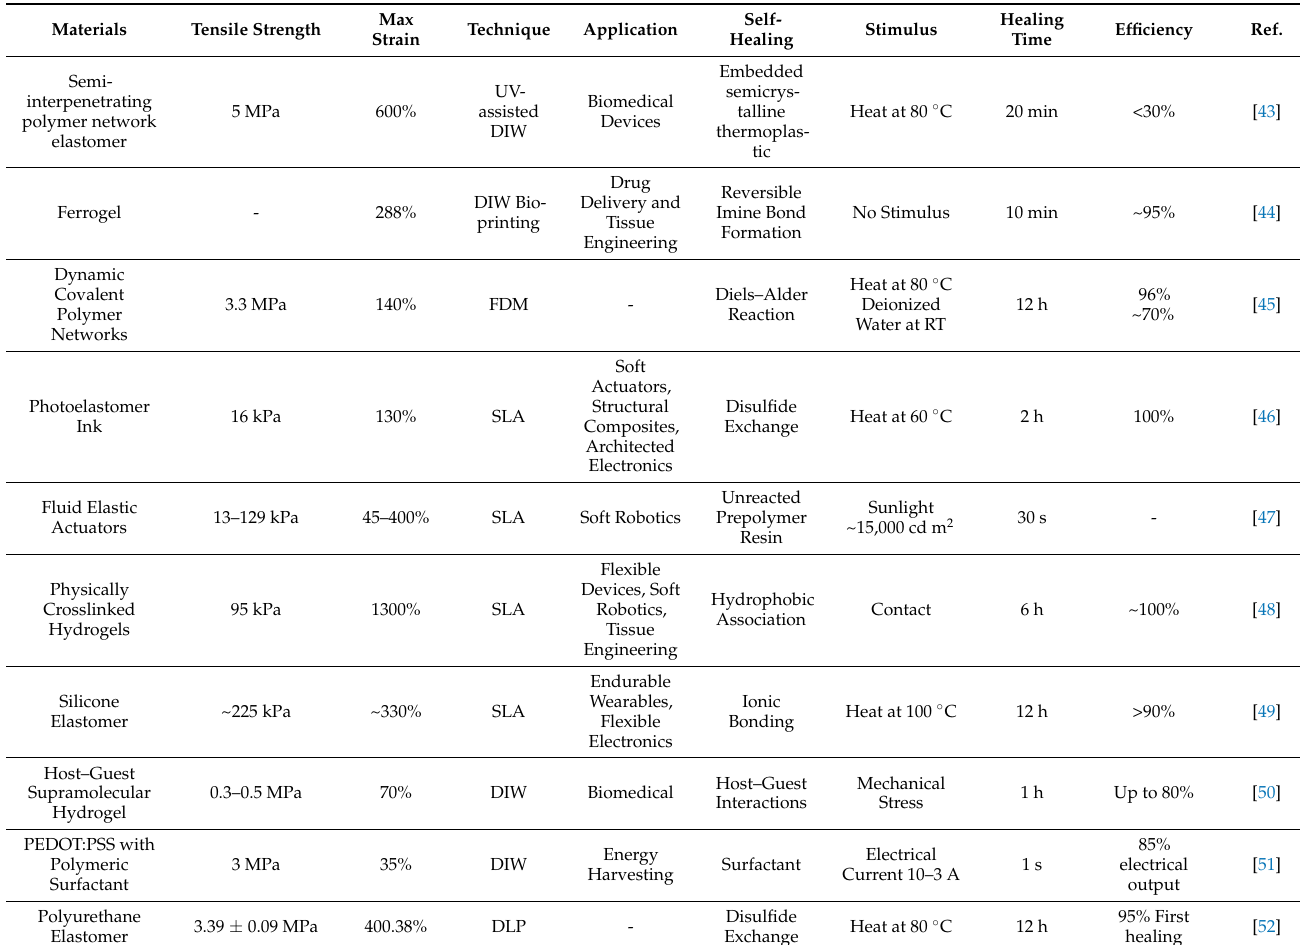
Table 3. Summary of recent studies on AM processable self-healing polymers highlighting mechanical robustness and healing